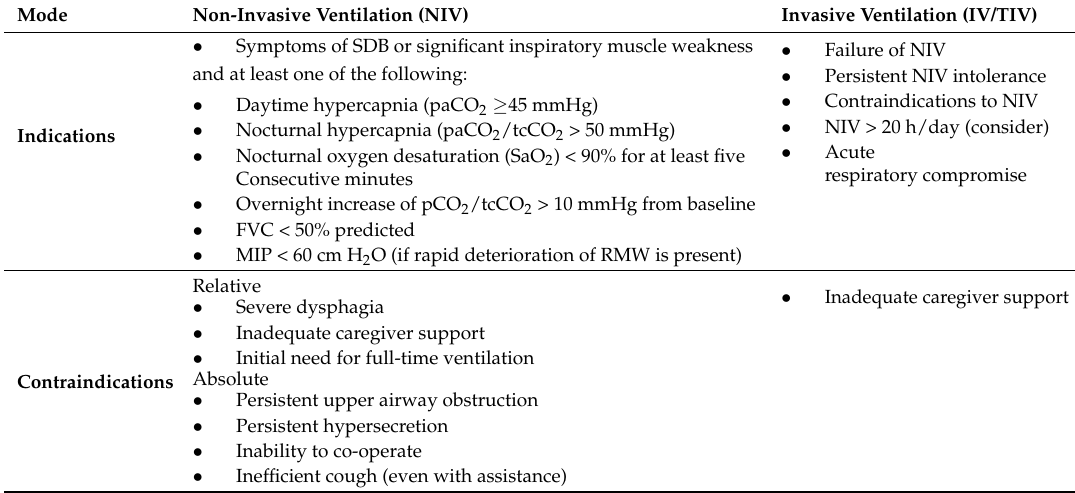
Table 2. General indications and contraindications for the initiation of long-term positive pressure ventilation in patients with neuromuscular disease [26]. FVC, forced vital capacity; MIP, maximal inspiratory pressure; SDB, sleep-disordered breathing; paCO 2 , partial pressure of carbon dioxide; RMW, respiratory muscle weakness; saO 2 , oxygen saturation; tcCO 2 , transcutaneous carbon dioxide tension; TIV, tracheostomy invasive